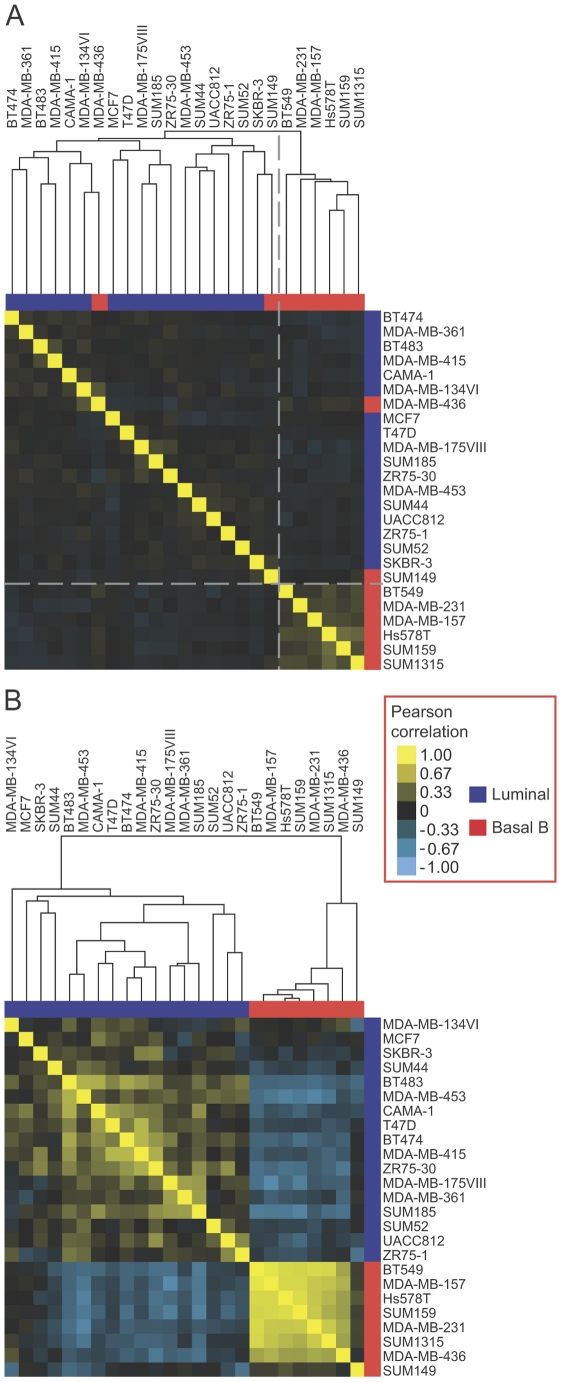
EMT–associated alternative mRNA isoforms classify breast cancer subtypes.(A) Unsupervised hierarchical clustering of NCI-60 breast cancer cell lines [39], as indicated, using the 307 EMT-associated SE events (|ΔΨ|>0.1, FDR<0.05). Luminal cell lines are marked in blue. Basal B cell lines are marked in red. Shades of yellow indicate positive pearson correlation. Shades of blue indicate negative pearson correlation. The color scale is shown on the right. The dotted line separates luminal and basal cell line clusters. (B) Clustering correlation matrix of NCI-60 breast cancer cell lines [39], as indicated, using the 24 coherent events.